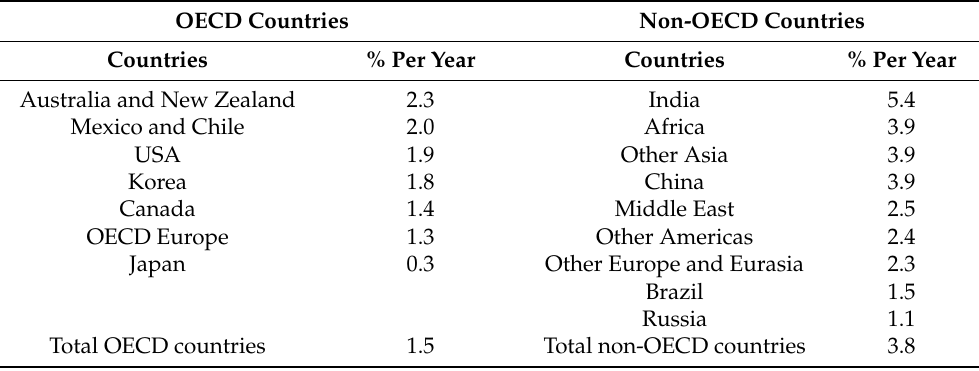
Table 1. Average annual percent change in gross domestic product (GDP) in 2018–2050—own study based on data [2,3].